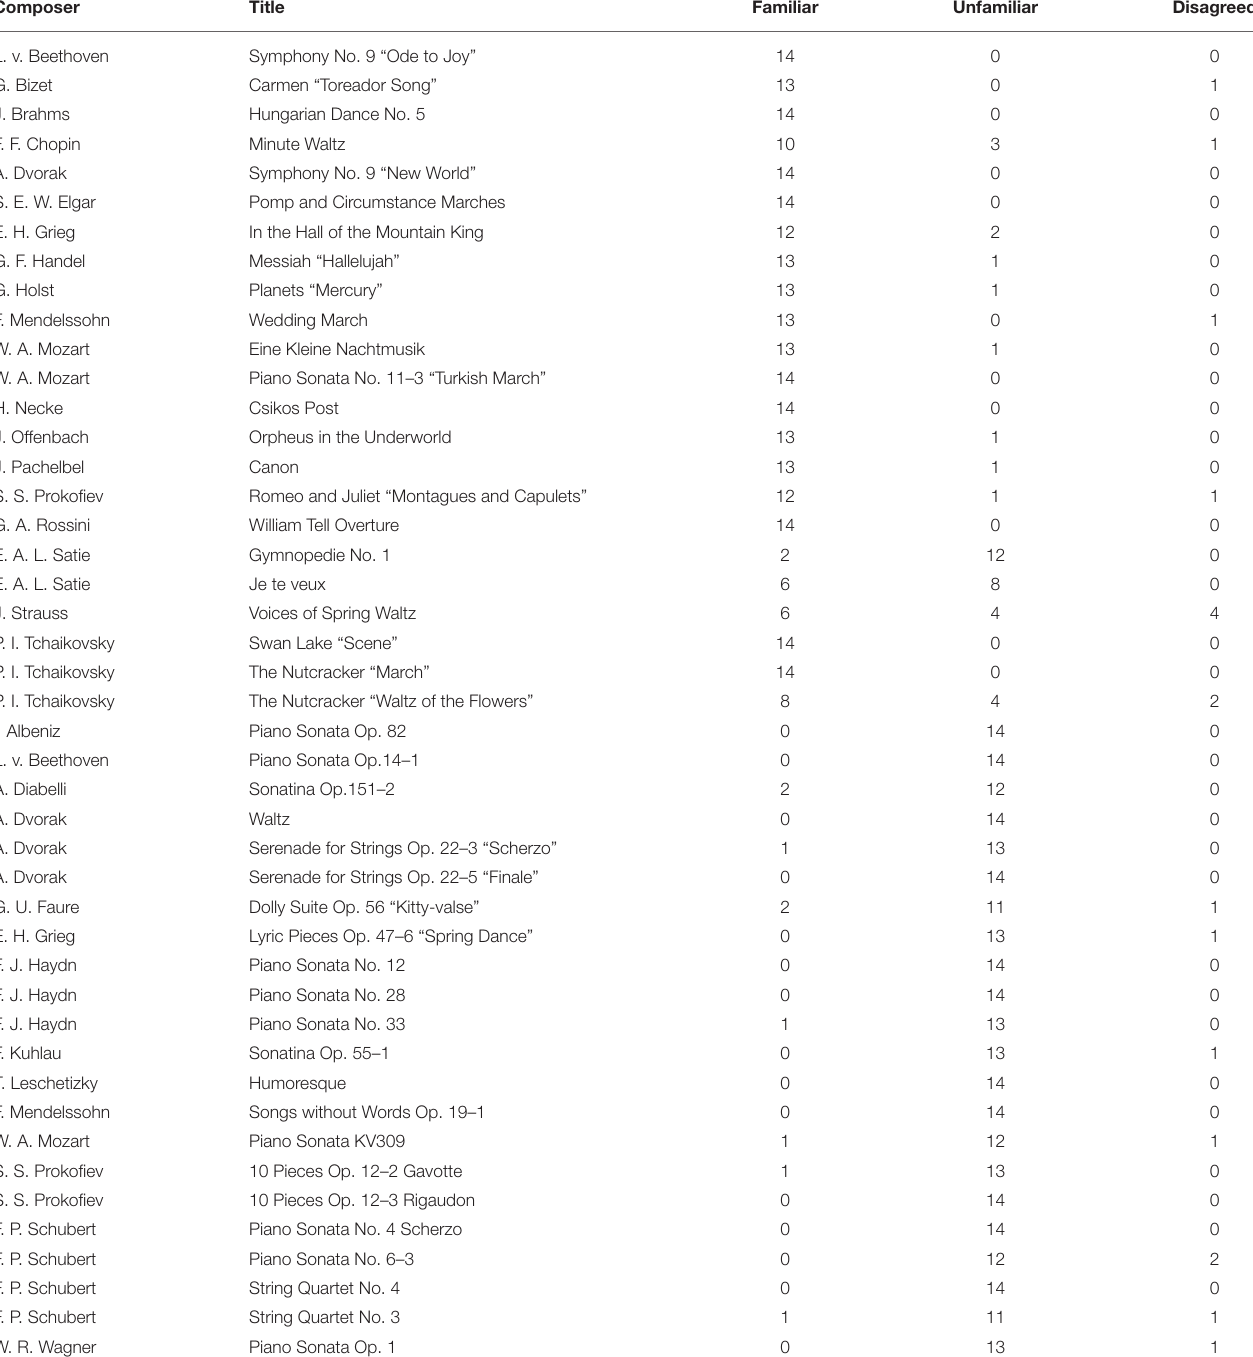
TABLE 1 | Music for the audio